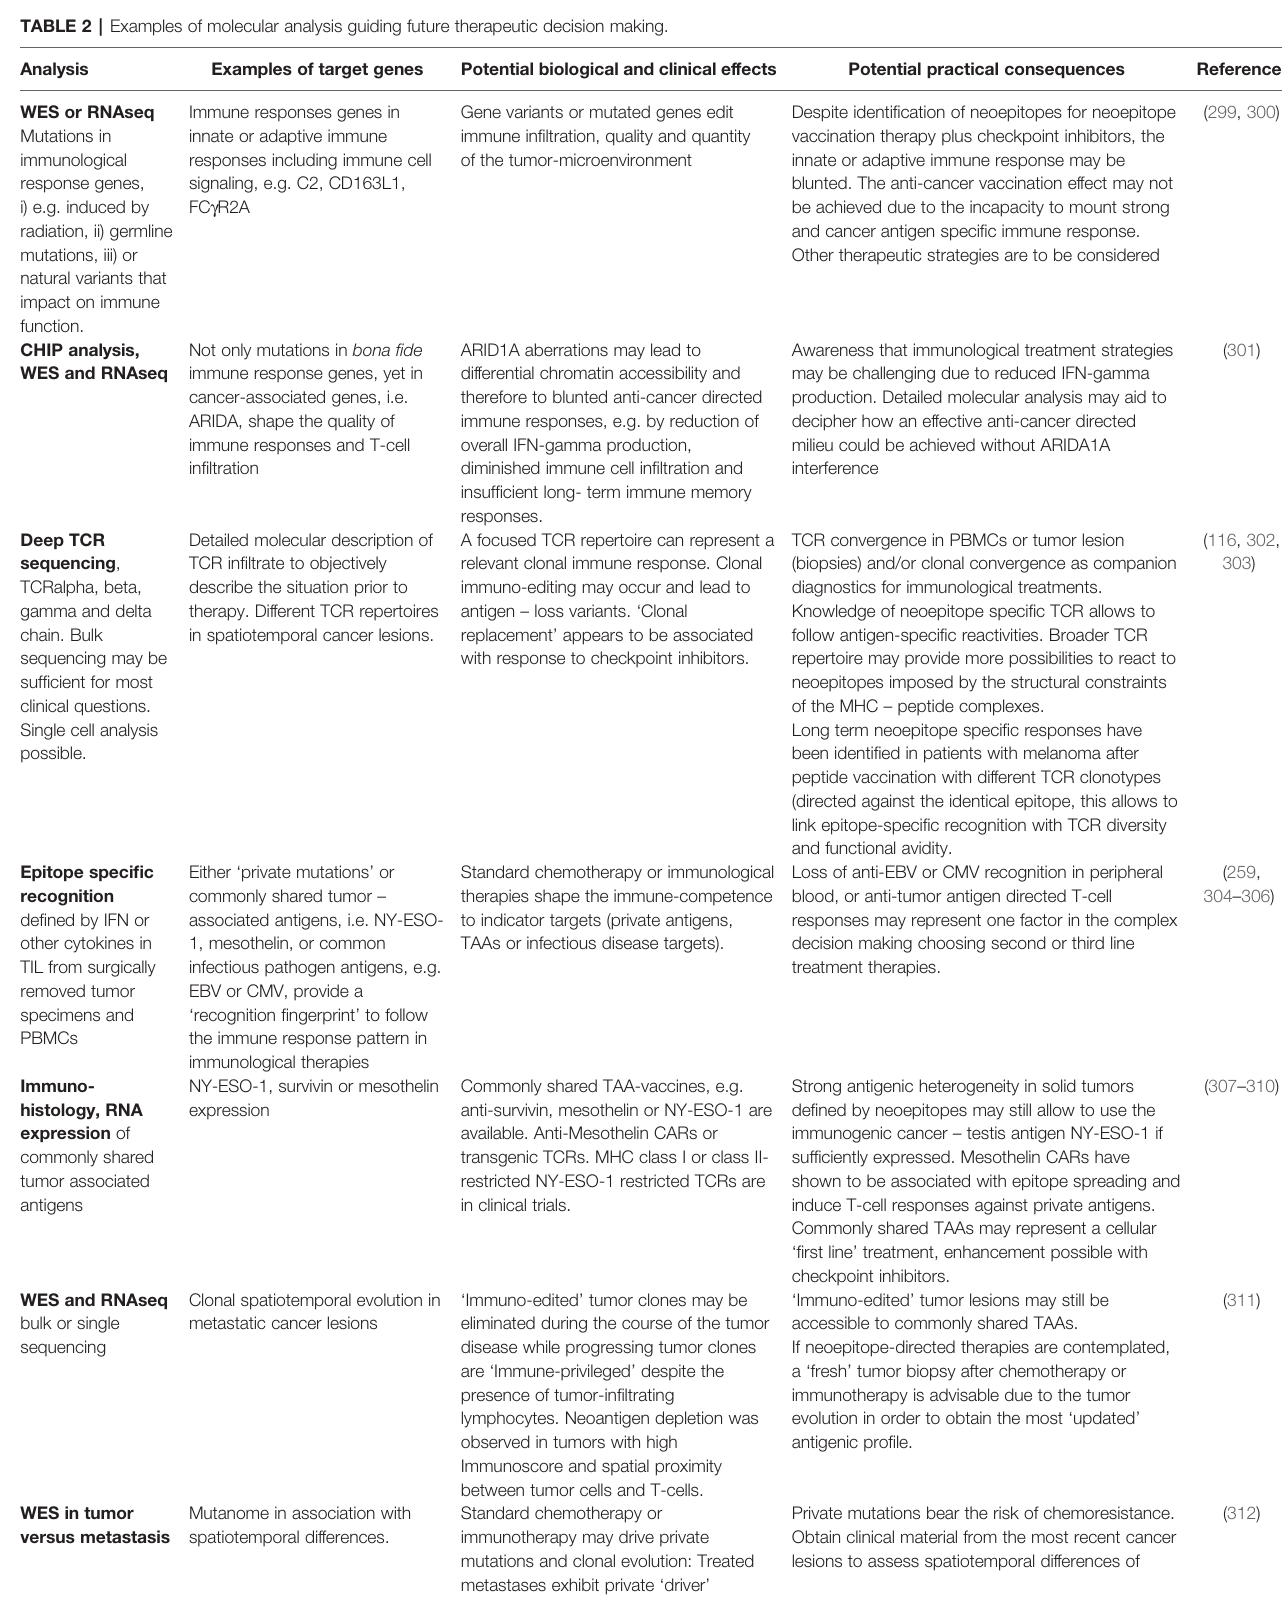
TABLE 2 | Examples of molecular analysis guiding future therapeutic decision